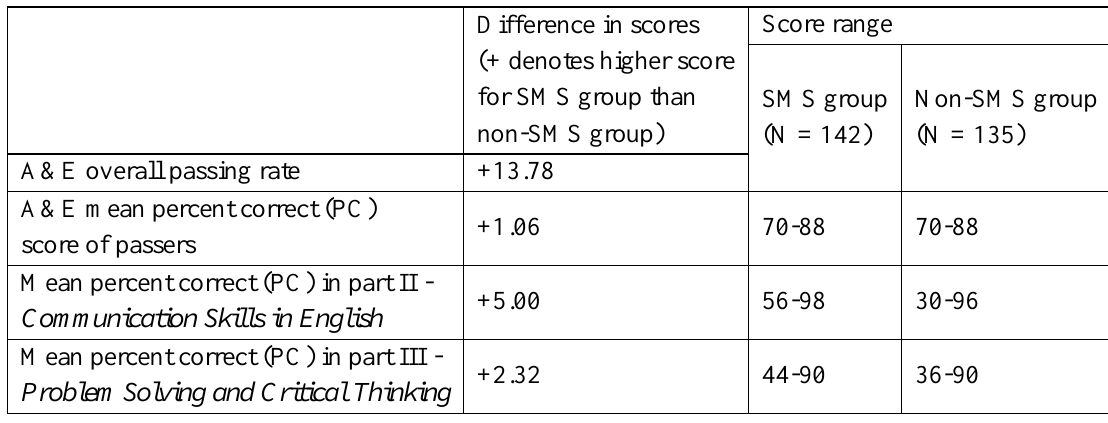
Results of ALS Accreditation and Equivalency Exam for Parts II and III (Adapted from Ramos, 2008, p.